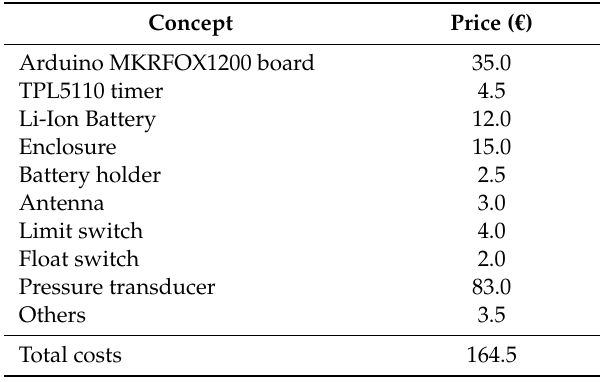
Table 3. Production costs of the IoT pressure